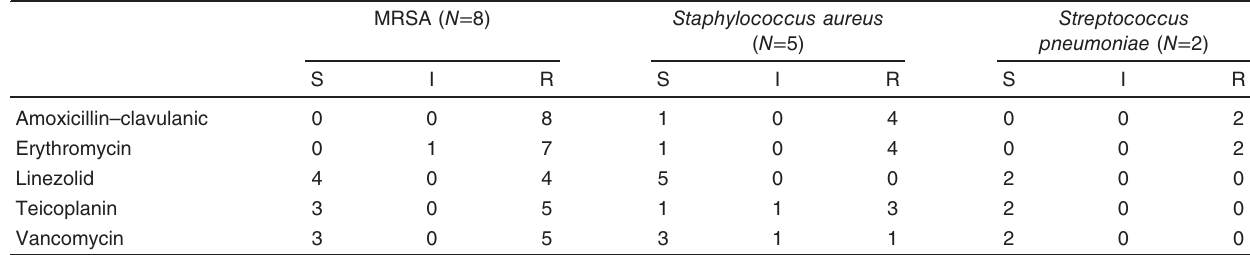
Table 4 Sensitivity of the organisms to second group of antibiotics